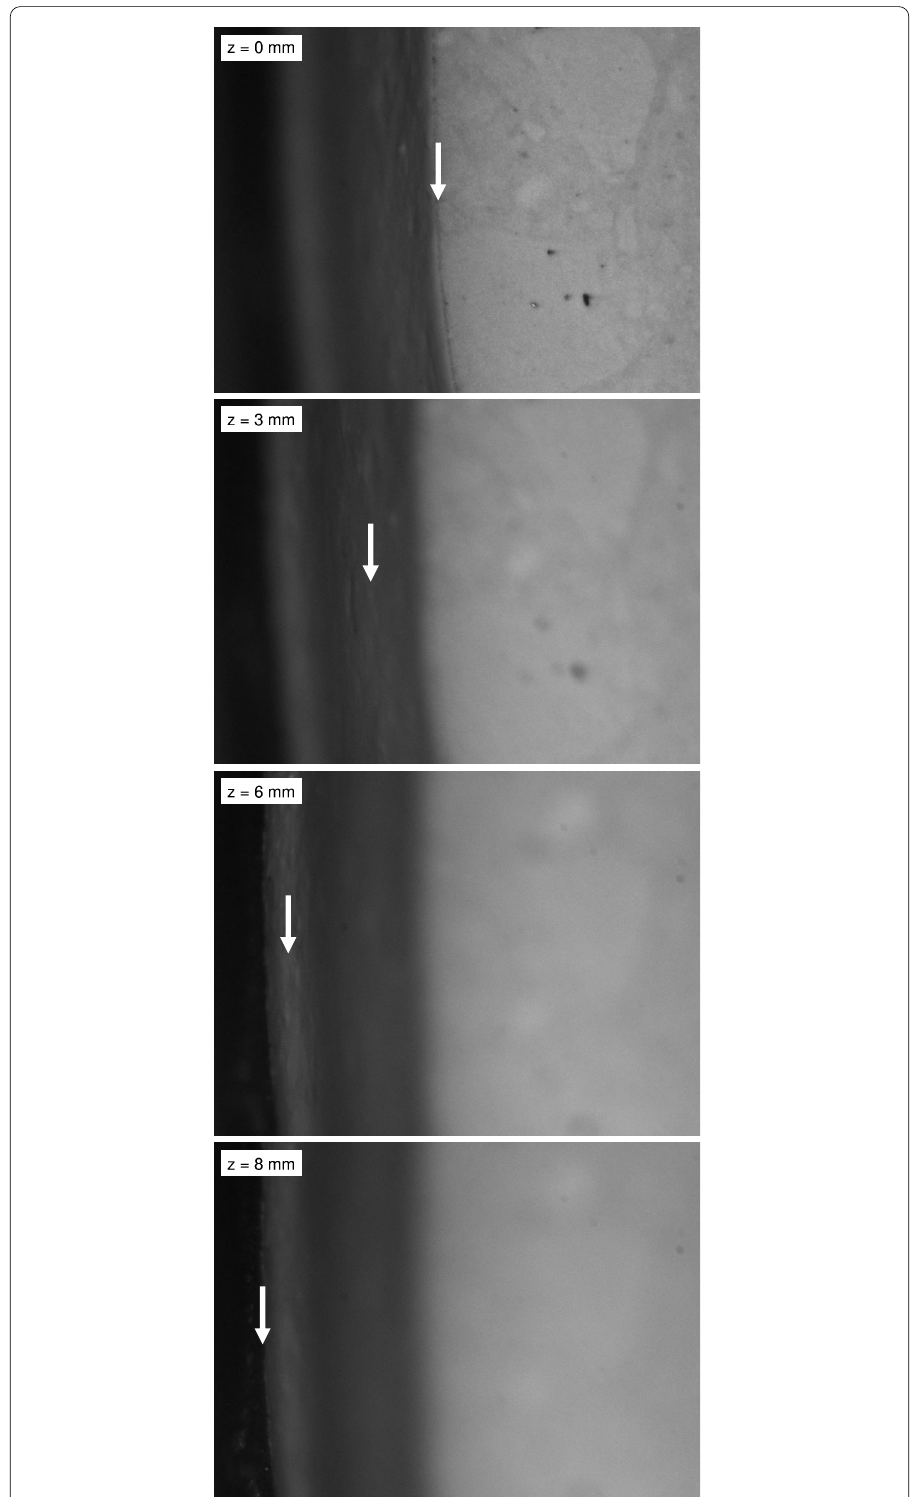
Figure 17 Telemicroscope images of a channel wall edge of the SPT-100D at different object distances. As indicated by arrows, the focal point moves along the eroded slope. Images were taken after about 300 hours of